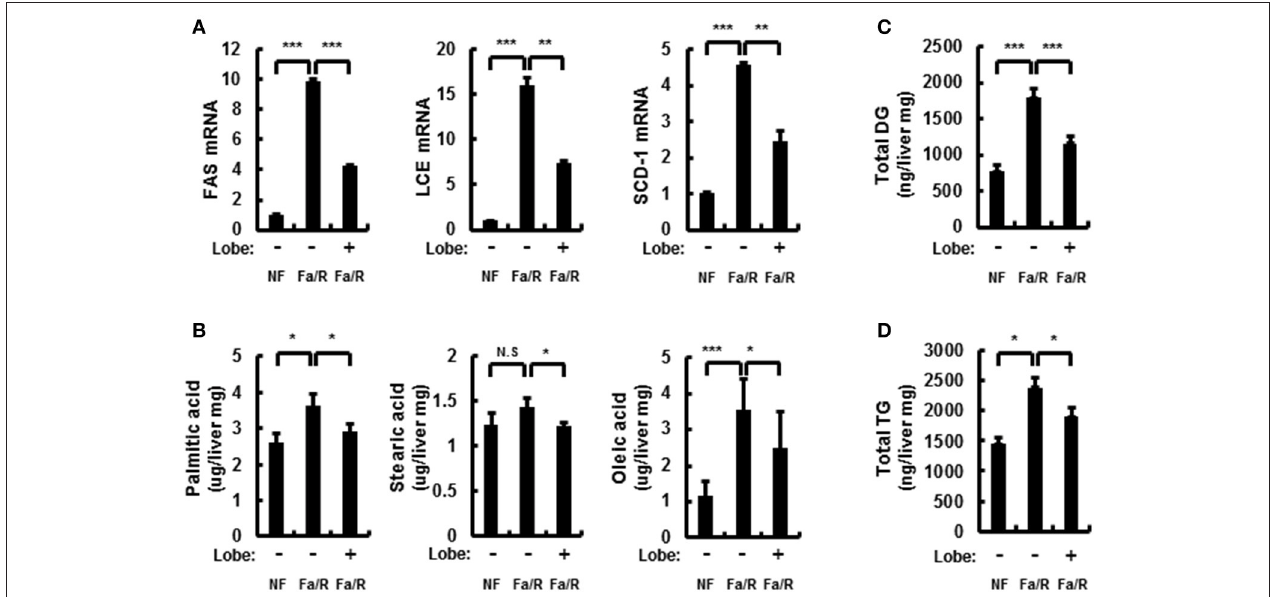
FIGURE 3 | Lobeglitazone inhibits hepatic lipogenesis. (A–D) Mice were maintained in a non-fasted state (NFa) ( n = 8) or fasted overnight and then refed a high-carbohydrate, fat-free diet (Fa/R) with vehicle ( n = 9) or lobeglitazone ( n = 9). (A) The total RNA isolated from liver was subjected to qRT-PCR analysis of FAS, SCD-1, and LCE mRNAs. The data are presented relative to the corresponding value for non-fasted mice. (B) The livers of eight or nine mice in each group were homogenized. The lipids from the homogenates were subjected to hydrolysis and acidic transmethylation, and then detected by GC-MS. Fatty acid content of palmitic acid, stearic acid, and oleic acid expressed per milligram of liver. (C,D) The livers of eight or nine mice in each group were homogenized. The lipids from the homogenates were subjected to hydrolysis and acidic transmethylation, and then detected by LC-MS. Lipid content of DG and TG expressed per milligram of liver. Data in (A,D) are the mean ± standard error for eight or nine mice in each group. * p < 0.05, ** p < 0.01, and *** p < 0.001.